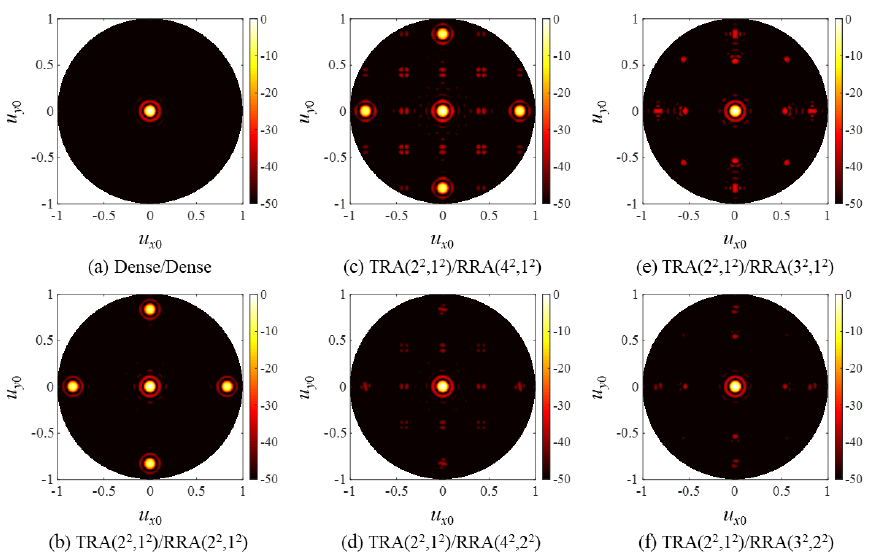
Figure 7. Two-way, CW point spread functions (PSFs) of ( a ) the dense array pair and ( b – f ) the SRA pairs.